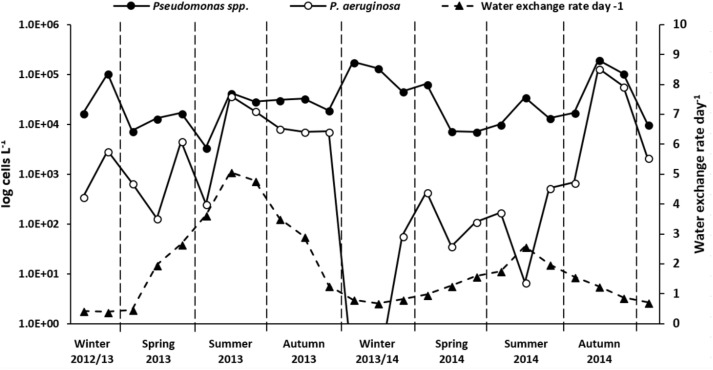
Absolute Pseudomonas species and P. aeruginosa quantification results from January 2013 to December 2014. Data are given as cells per liter of cooling tower water. Note the log transformation of left y-axis. Pseudomonas species cell counts (filled circle, continuous line) represent mean after replicates (n = 3) analysis by qPCR. P. aeruginosa cell counts (empty circle, solid line) calculated as a function of relative abundances obtained from NGS Pseudomonas community analysis. Water exchange rate values per day (filled triangles, dashed line) are also shown. Winter, December to February; spring, March to May; summer, June to August; autumn, September to November.